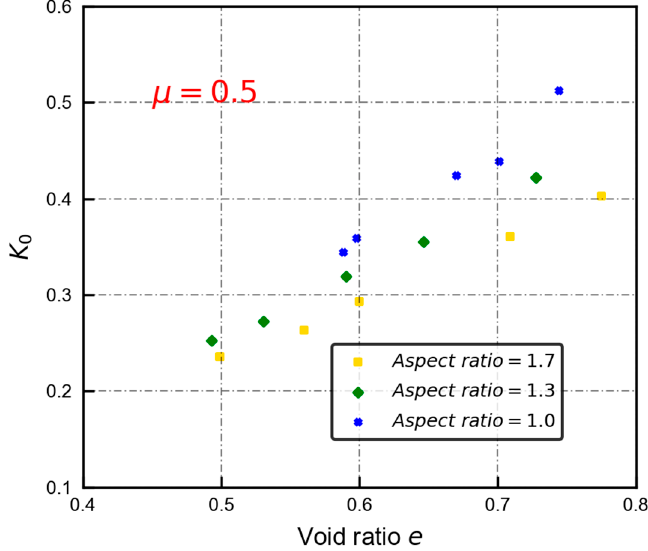
Figure 14. K 0 versus initial void ratios for specimens at different aspect ratios.